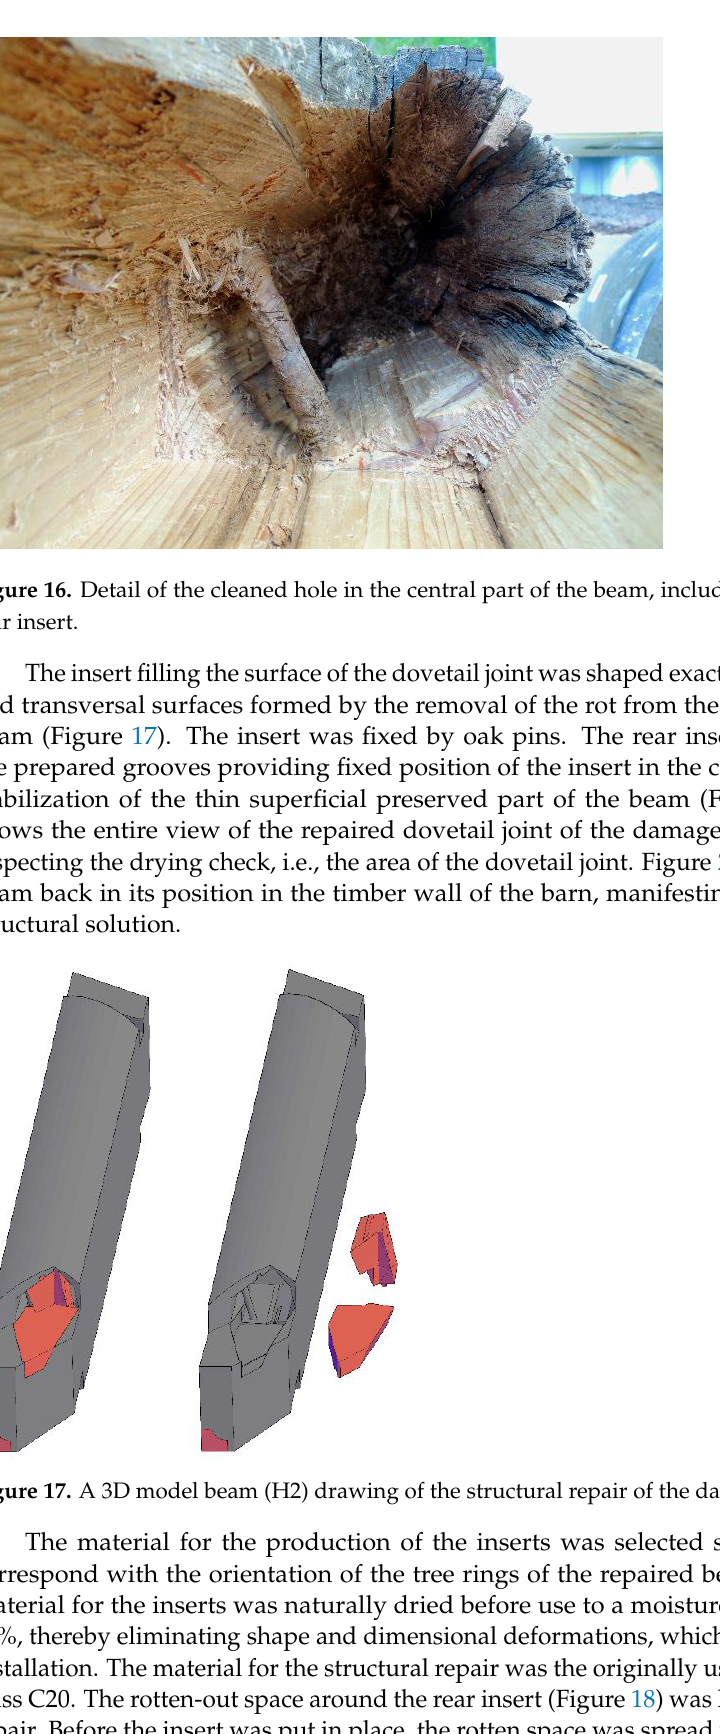
Figure 15. Detail of the damaged beam end before the repair, the end integrity ensured by the knot near the drying check.